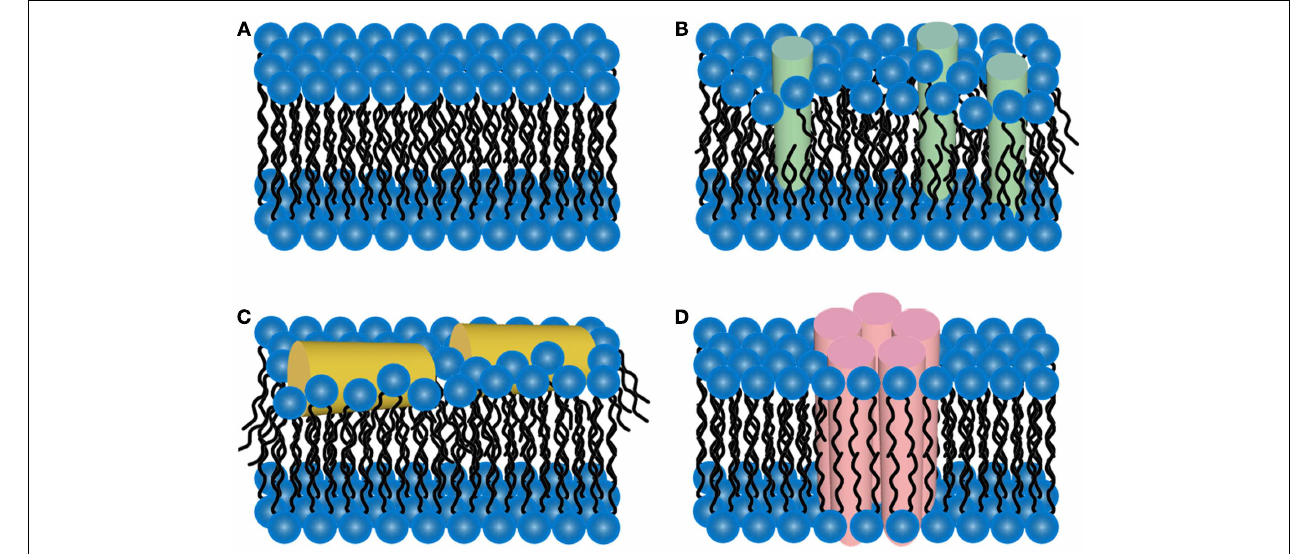
lipid-binding domains. Such scenarios could lead to membrane thinning and non-specific membrane leakage. (D) Many amyloid-forming proteins have been shown to form pore-like structures that can act as unregulated ion-selective